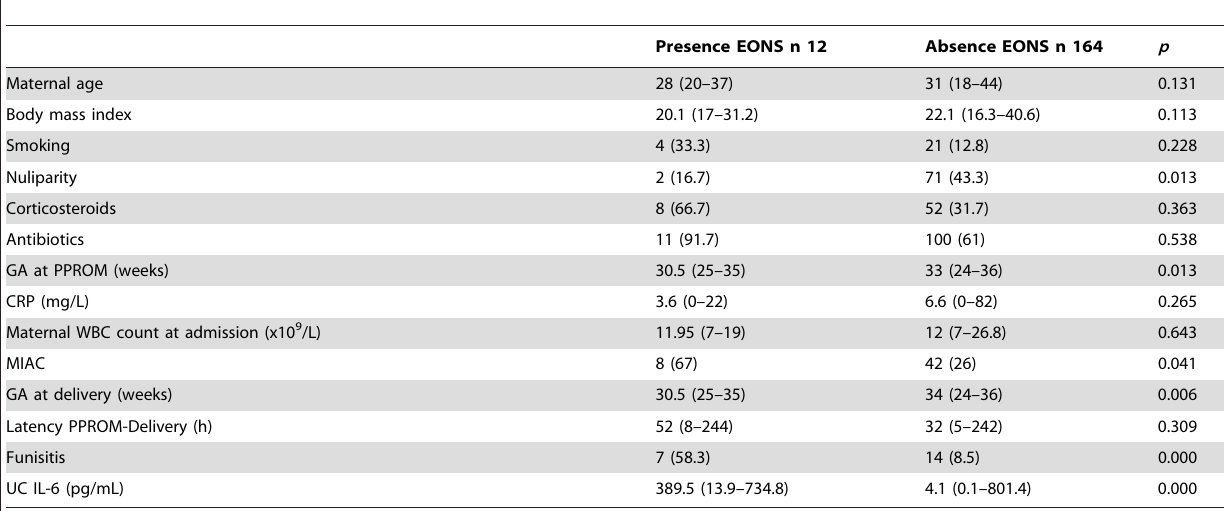
Table 1. Maternal outcomes according the presence or absence of early-onset neonatal sepsis.